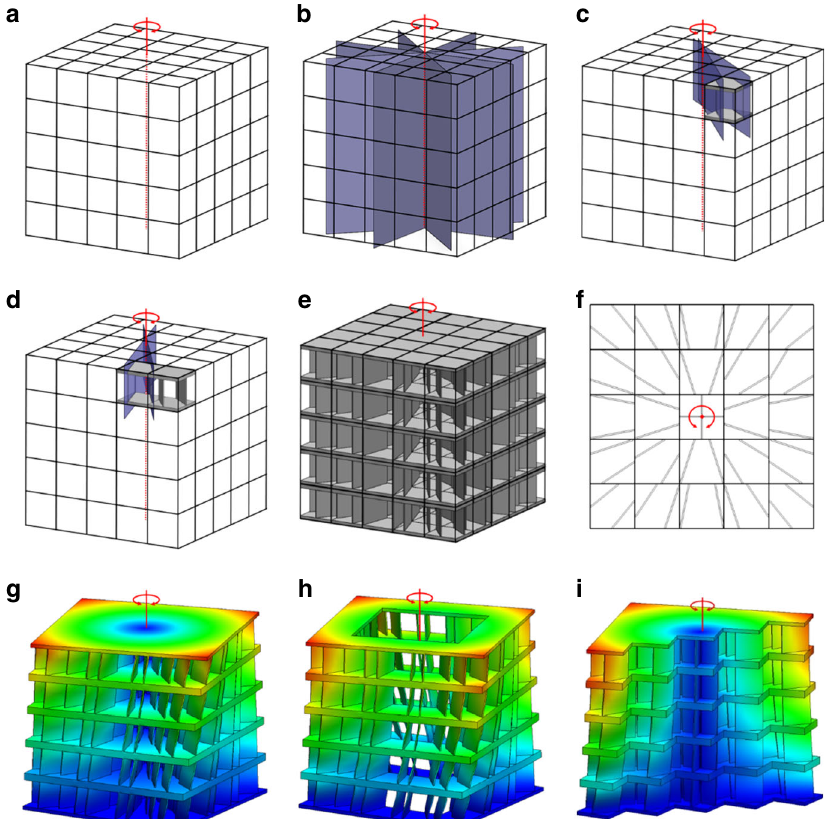
Fig. 4 Example with a rotational degree-of-freedom (DOF). a A rotational freedom space and, b its constraint space of intersecting planes can be used, c , d , to synthesize individual cells that individually achieve the desired rotation so, e , an aperiodic directionally compliant metamaterial (DCM) with, f intersecting blade elements can be generated to achieve, g – i , the desired rotation for a variety of bulk shapes (colors in g – i are de fi ned in Fig.